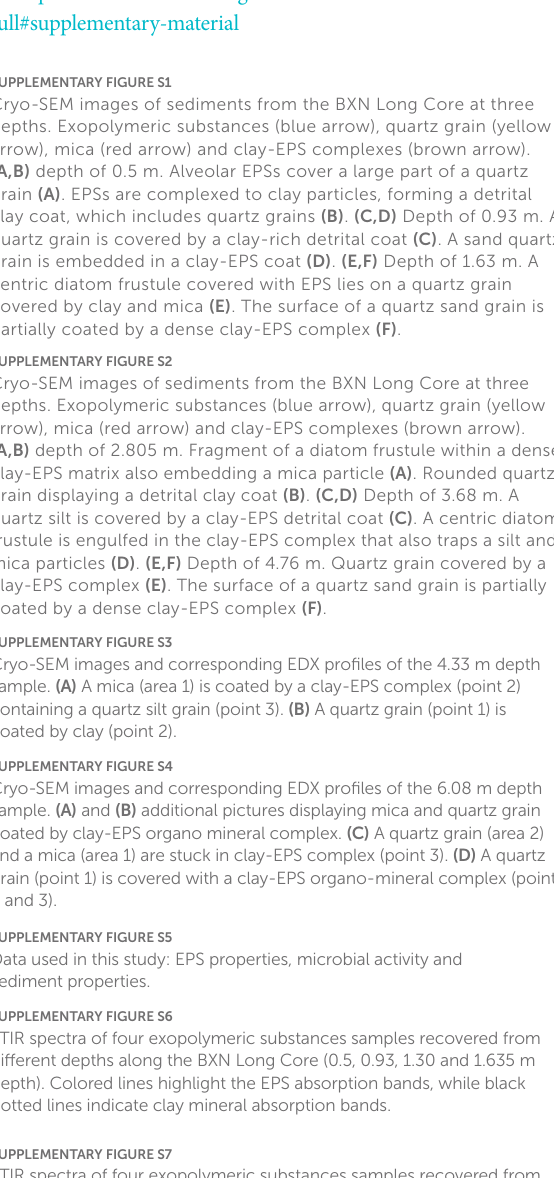
SUPPLEMENTARY FIGURE S1 Cryo-SEM images of sediments from the BXN Long Core at three depths. Exopolymeric substances (blue arrow), quartz grain (yellow arrow), mica (red arrow) and clay-EPS complexes (brown arrow). (A,B) depth of 0.5 m. Alveolar EPSs cover a large part of a quartz grain (A) . EPSs are complexed to clay particles, forming a detrital clay coat, which includes quartz grains (B) . (C,D) Depth of 0.93 m. A quartz grain is covered by a clay-rich detrital coat (C) . A sand quartz grain is embedded in a clay-EPS coat (D) . (E,F) Depth of 1.63 m. A centric diatom frustule covered with EPS lies on a quartz grain covered by clay and mica (E) . The surface of a quartz sand grain is partially coated by a dense clay-EPS complex (F) . SUPPLEMENTARY FIGURE S2 Cryo-SEM images of sediments from the BXN Long Core at three depths. Exopolymeric substances (blue arrow), quartz grain (yellow arrow), mica (red arrow) and clay-EPS complexes (brown arrow). (A,B) depth of 2.805 m. Fragment of a diatom frustule within a dense clay-EPS matrix also embedding a mica particle (A) . Rounded quartz grain displaying a detrital clay coat (B) . (C,D) Depth of 3.68 m. A quartz silt is covered by a clay-EPS detrital coat (C) . A centric diatom frustule is engulfed in the clay-EPS complex that also traps a silt and mica particles (D) . (E,F) Depth of 4.76 m. Quartz grain covered by a clay-EPS complex (E) . The surface of a quartz sand grain is partially coated by a dense clay-EPS complex (F) . SUPPLEMENTARY FIGURE S3 Cryo-SEM images and corresponding EDX profiles of the 4.33 m depth sample. (A) A mica (area 1) is coated by a clay-EPS complex (point 2) containing a quartz silt grain (point 3). (B) A quartz grain (point 1) is coated by clay (point 2). SUPPLEMENTARY FIGURE S4 Cryo-SEM images and corresponding EDX profiles of the 6.08 m depth sample. (A) and (B) additional pictures displaying mica and quartz grain coated by clay-EPS organo mineral complex. (C) A quartz grain (area 2) and a mica (area 1) are stuck in clay-EPS complex (point 3). (D) A quartz grain (point 1) is covered with a clay-EPS organo-mineral complex (points 2 and 3). SUPPLEMENTARY FIGURE S5 Data used in this study: EPS properties, microbial activity and sediment properties. SUPPLEMENTARY FIGURE S6 FTIR spectra of four exopolymeric substances samples recovered from different depths along the BXN Long Core (0.5, 0.93, 1.30 and 1.635 m depth). Colored lines highlight the EPS absorption bands, while black dotted lines indicate clay mineral absorption bands. SUPPLEMENTARY FIGURE S7 FTIR spectra of four exopolymeric substances samples recovered from different depths along the BXN Long Core (2.16, 2.595, 2.805 and 3.25 m depth). Colored lines highlight the EPS absorption bands, while black dotted lines indicate clay mineral absorption